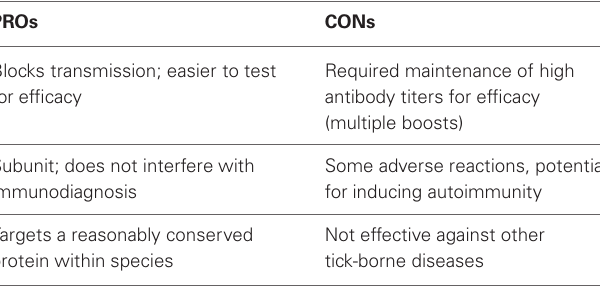
Table 2 | Positive and negative characteristics of the OspA